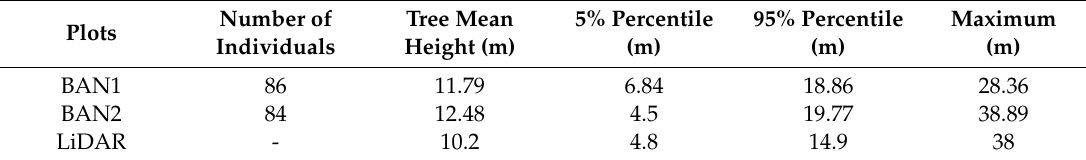
Table 2. Experimental plots and LiDAR statistics regarding tree height measurements. Plots